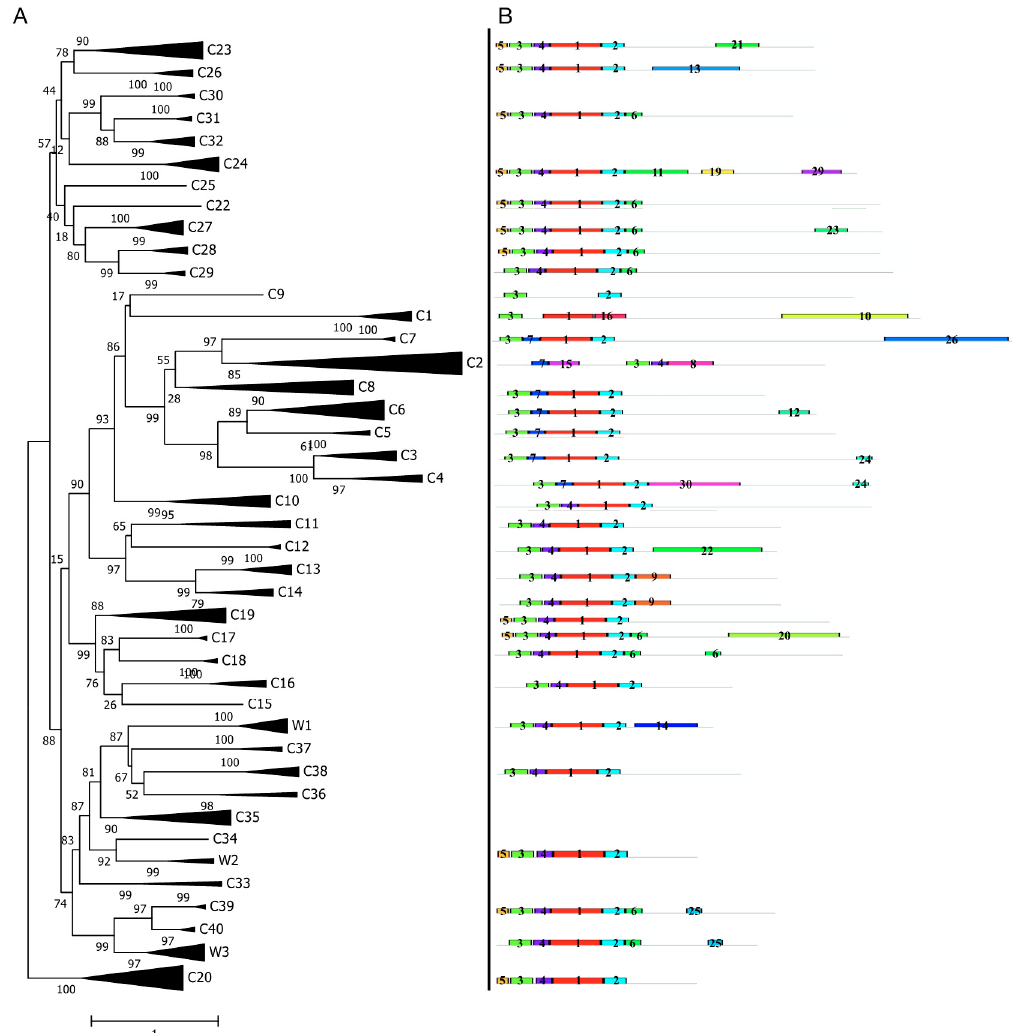
Figure 2. Phylogenetic relationship and representative conserved motif patterns in different pecan R2R3-MYB clades. Phylogenetic relationship of different clades ( A ), and typical motif patterns of R2R3-MYB members in different clades were identified ( B ). Detailed information of the motif pattern of the pecan R2R3-MYB gene family is provided in Figure S3, and sequence information of each motif is listed in Table S4.